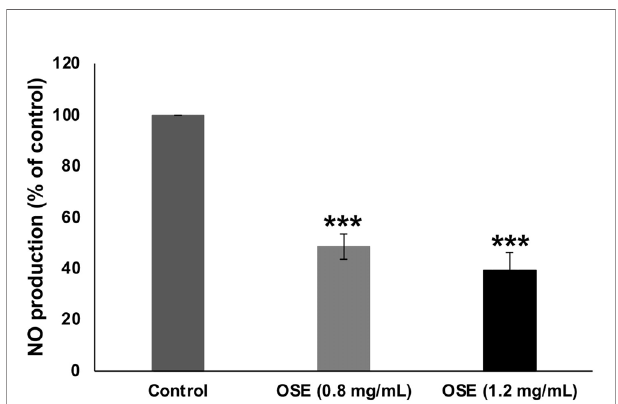
FIGURE 8 | OSE reduces NO in MDA-MB-231 cells. MDA-MB-231 cells were treated with OSE (0.8 and 1.2 mg/ml) for 24h and Nitrate/Nitrite production was quanti fi ed as described in Materials and Methods. Values are represented as mean ± SEM (***p